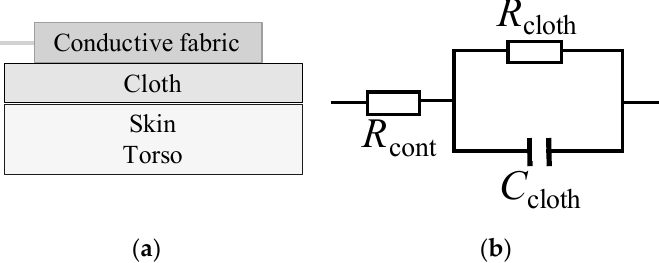
Figure 1. Illustration of the capacitive ECG (cECG) coupling ( a ) and the equivalent circuit of the capacitive coupling; ( b ) R cont is the contact resistance between the cloth and the electrode, R cloth is the resistance of the cloth, and C cloth is the capacitance of the cloth.